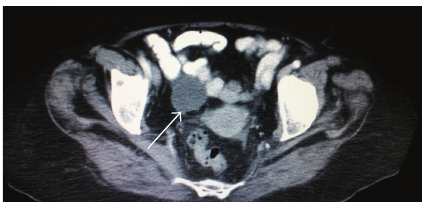
Figure 10: CT scan showing a swelling in the right iliac fossa (white arrow), misdiagnosed as ovarian cyst (second case).